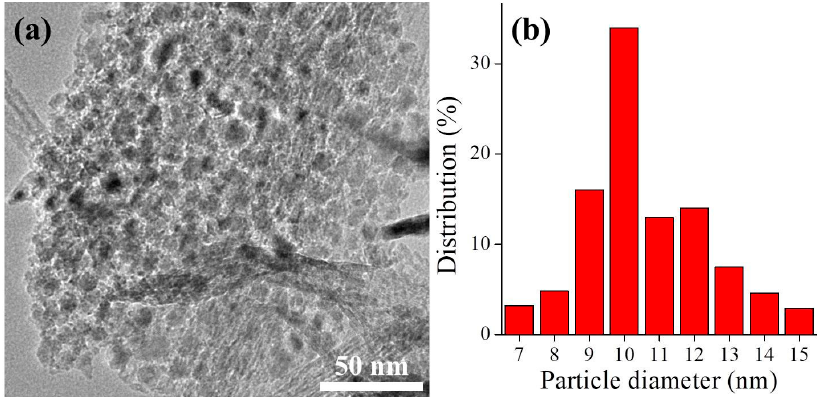
Figure 11. TEM ( a ) and particle size distribution ( b ) of the NiCo 0.5 Al-R-used catalyst.